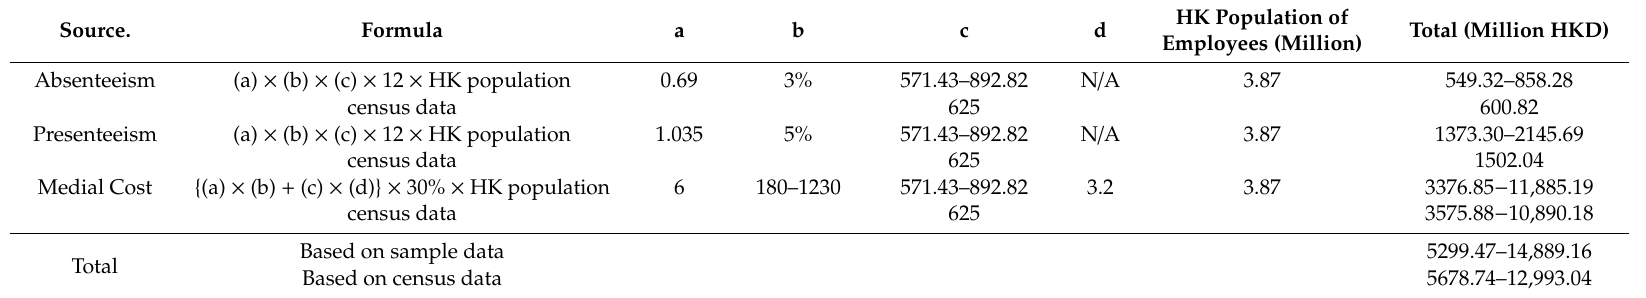
Table 4. Summary of